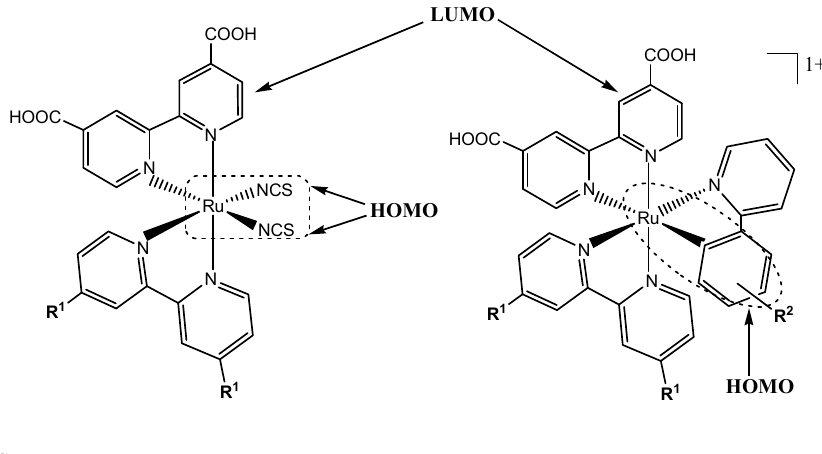
Figure 18. Ruthenium cyclometalated complex obtained through substitution of thiocyanate ligand with phenylpyridine ligand